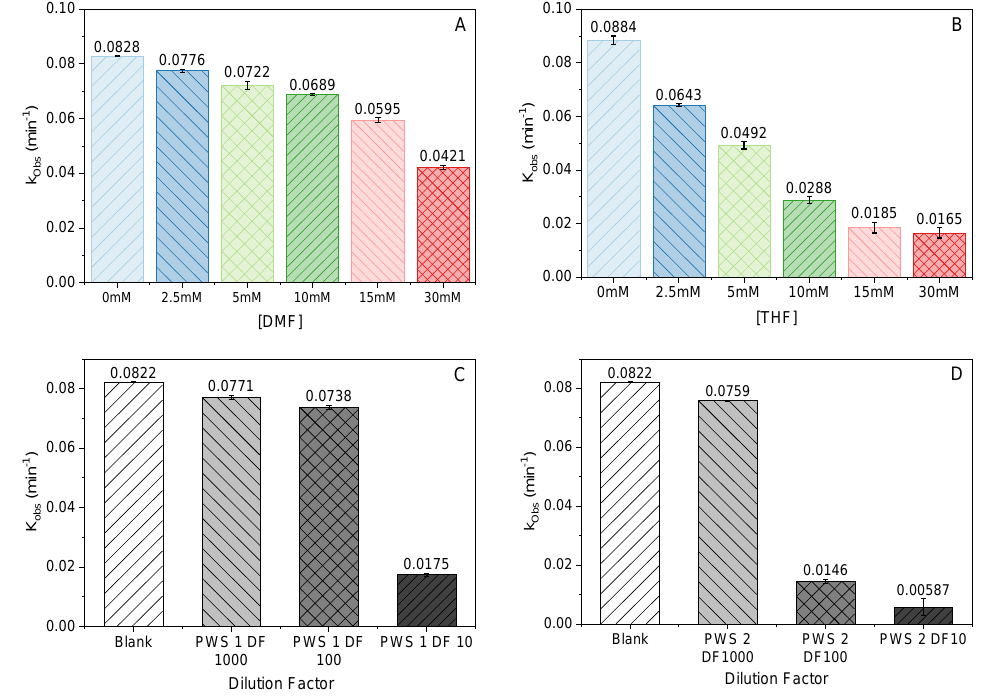
Figure 11. k obs , min − 1 for ( A ) varied concentrations of DMF, ( B ) varied concentrations of THF, ( C ) different dilution factors of PWS 1, and ( D ) different dilution factors of PWS